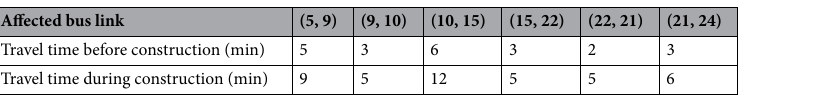
Table 3. Link travel time before and during